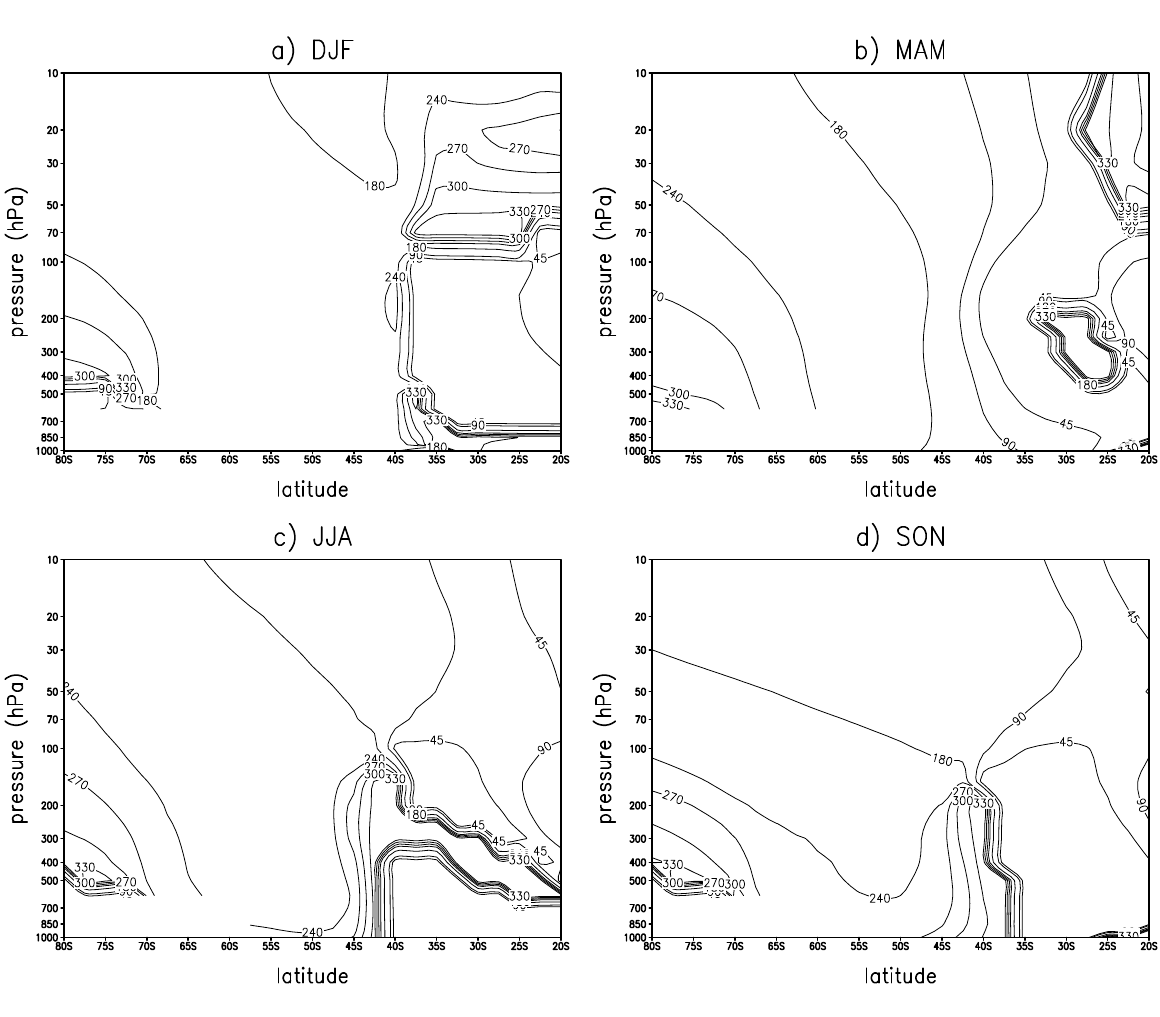
Fig. A2. Same as Fig. A1, but for the phase